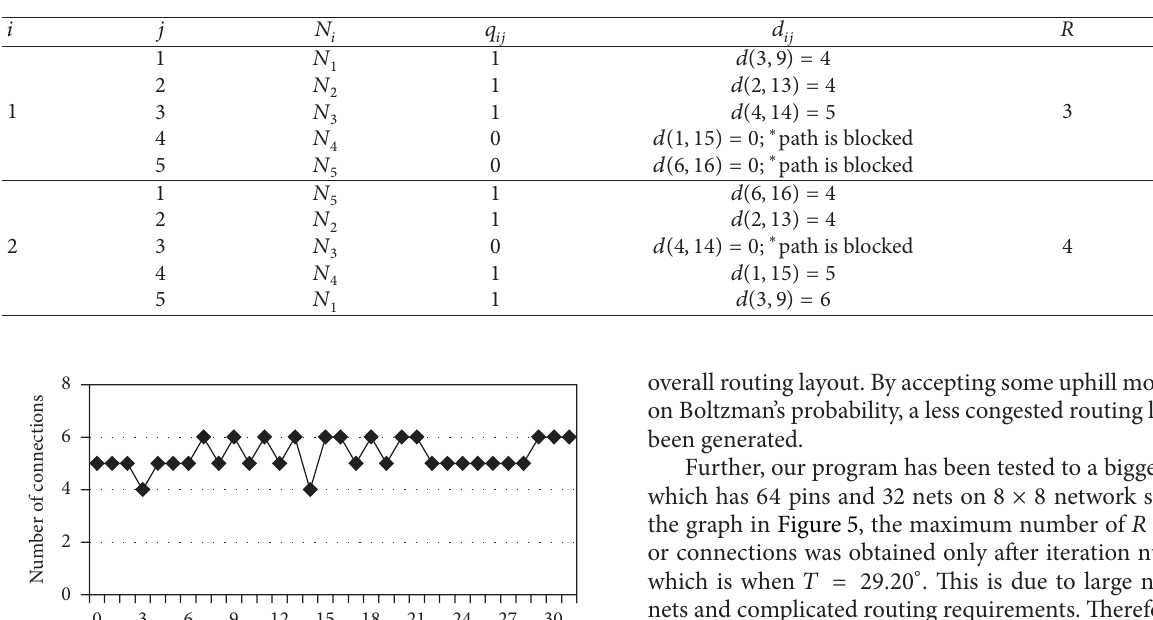
Table 2: Calculation of energy level in a routing region.